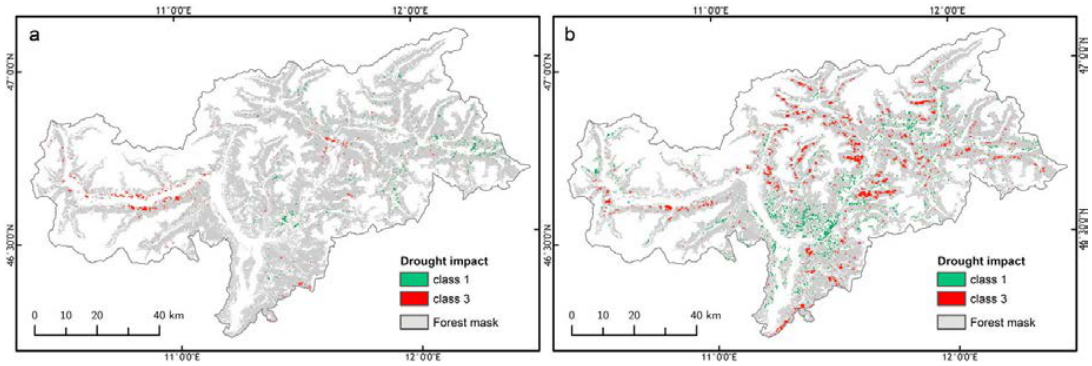
Figure 2. Spatial footprints of drought impact on forest recognized as: ( a ) changes in canopy water content—4nNDII7 PC; and ( b ) alternation in foliage photosynthetic activity—3nNDVI PC. Class 1 (green) represents the strongest negative, while class 3 (red) the strongest positive correlations of each principal component being projected on its respective vegetation index time series. Only values with p < 0.1 were considered. The forest mask is marked in gray.